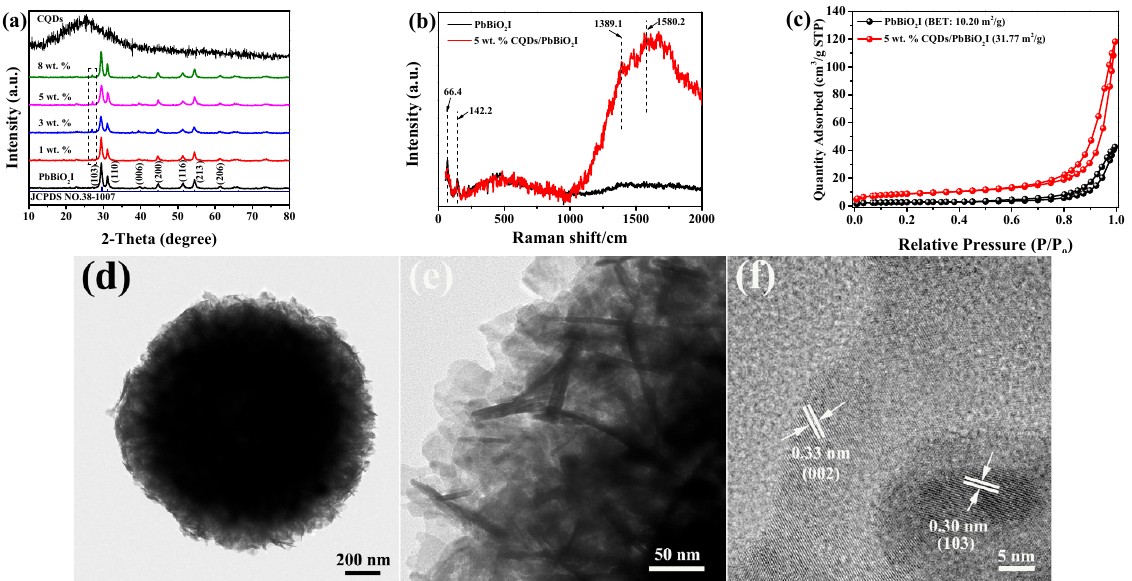
Figure 1. ( a ) XRD patterns of the as-prepared samples; ( b ) Raman spectra and ( c ) Nitrogen adsorption-desorption isotherms of PbBiO 2 I and 5 wt.% CQDs/PbBiO 2 I; ( d , e ) TEM and ( f ) HRTEM images of 5 wt.% CQDs/PbBiO 2 I.